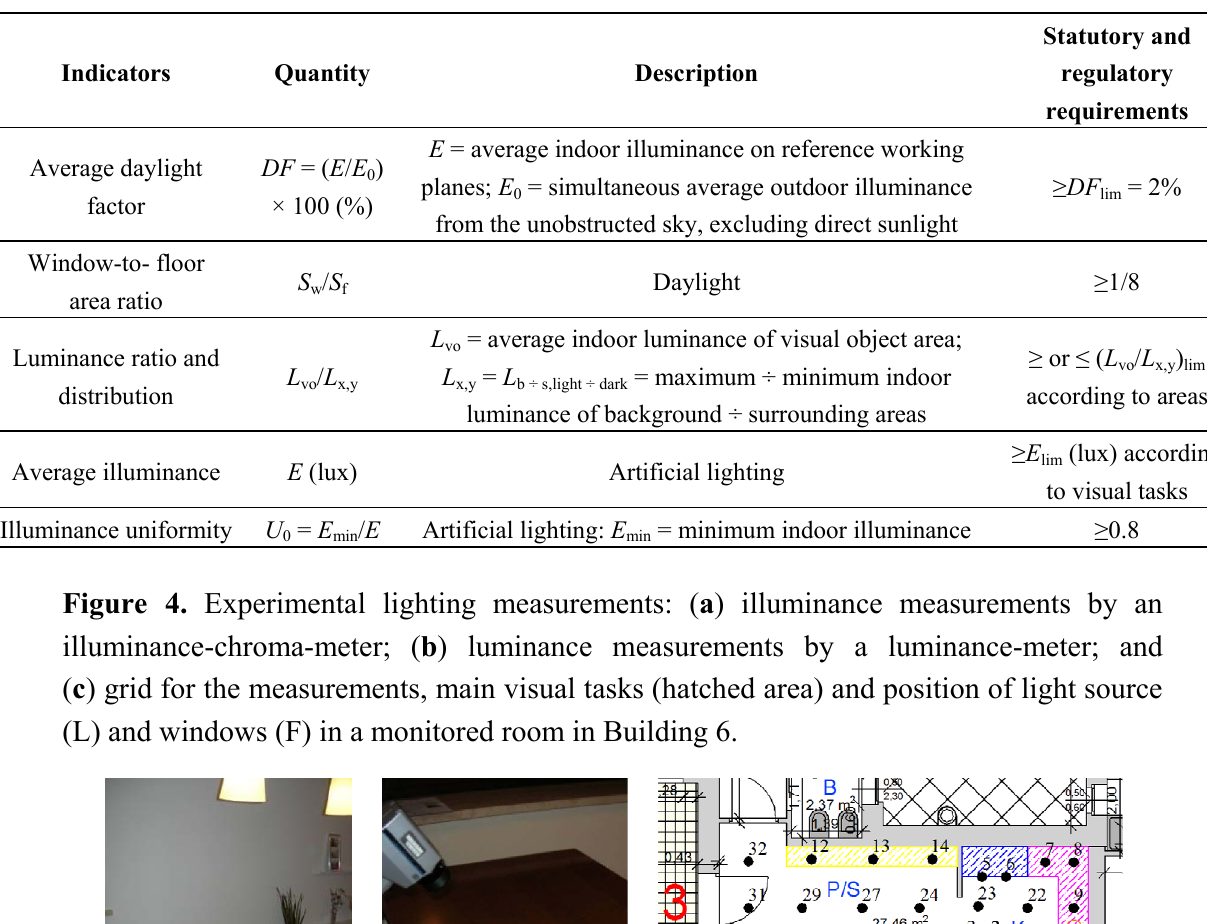
Table 2. Main indicators and limit values concerning indoor lighting performance.